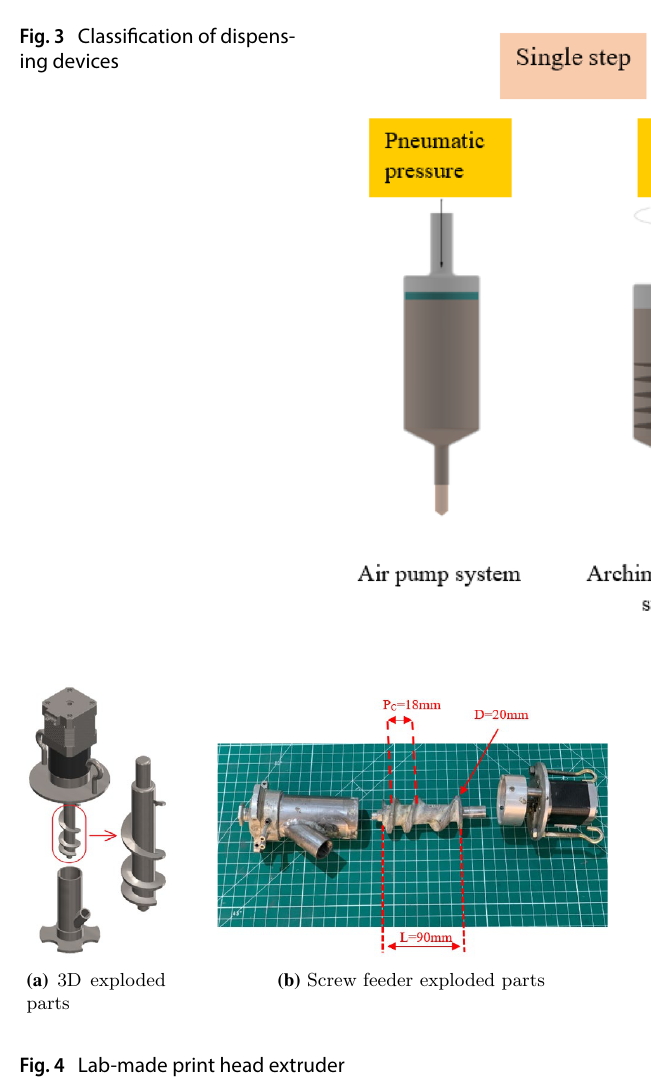
Fig. 4 Lab-made print head